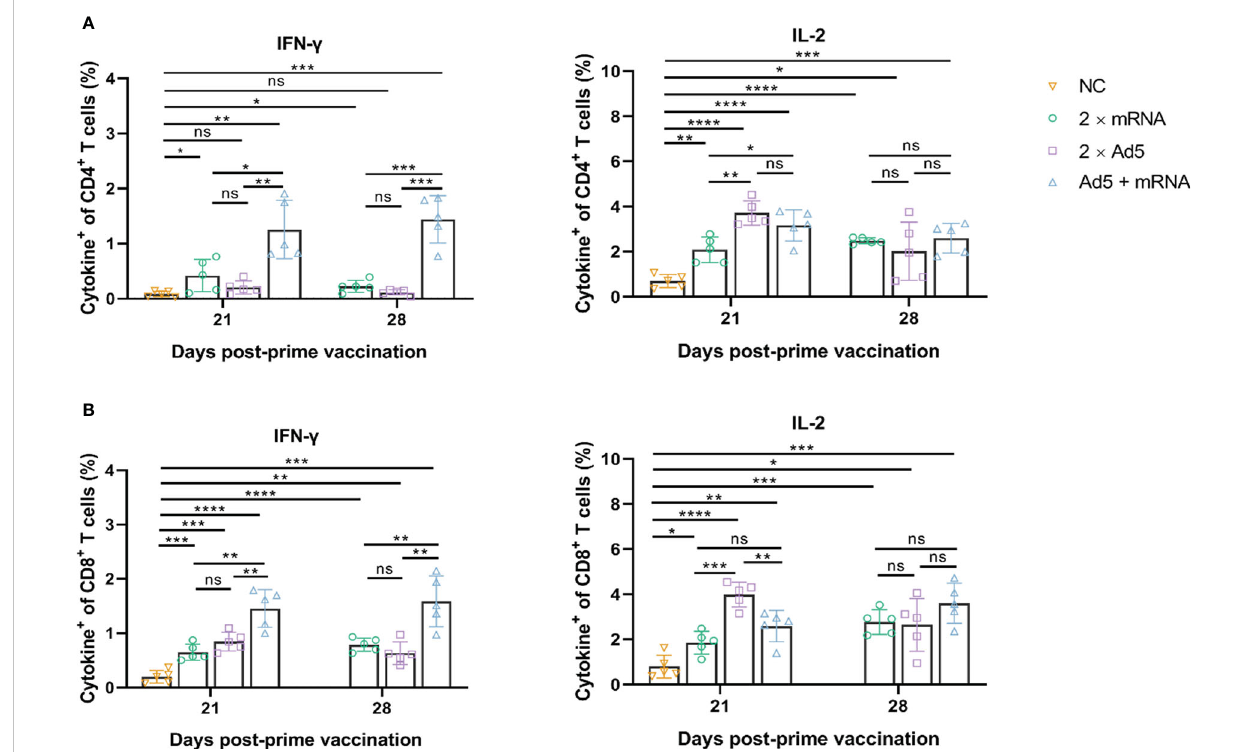
FIGURE 8 CD4 + and CD8 + T-cell responses induced by different immunization regimens. Mice in four groups were immunized with different prime-boost strategies and splenocytes were harvested and analyzed. Percentage of intracellular (A) IFN- g and IL-2 positive CD4 + T cells, and (B) CD8 + T cells determined by ICS. n = 5 per group; each data point represents the mean number of spots per well. * p < 0.05; ** p < 0.01; *** p < 0.001; **** p < 0.0001; ns: p > 0.05. NC, negative control; Ad5, replication-defective human type 5 adenovirus-vectored